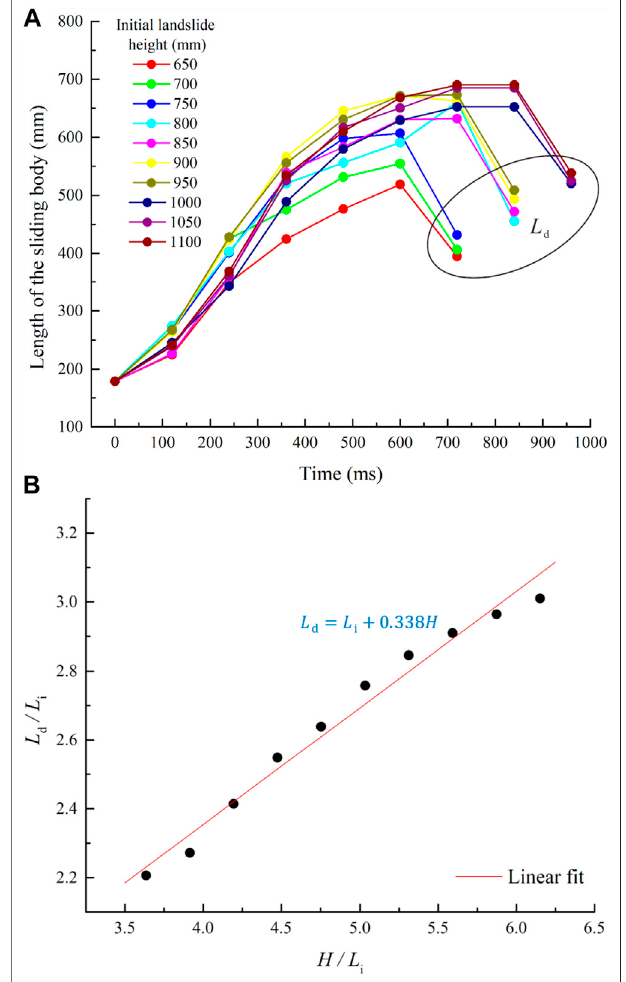
FIGURE 5 | (A) Variation in sliding body length during the landslide process and (B) lengths of deposits.